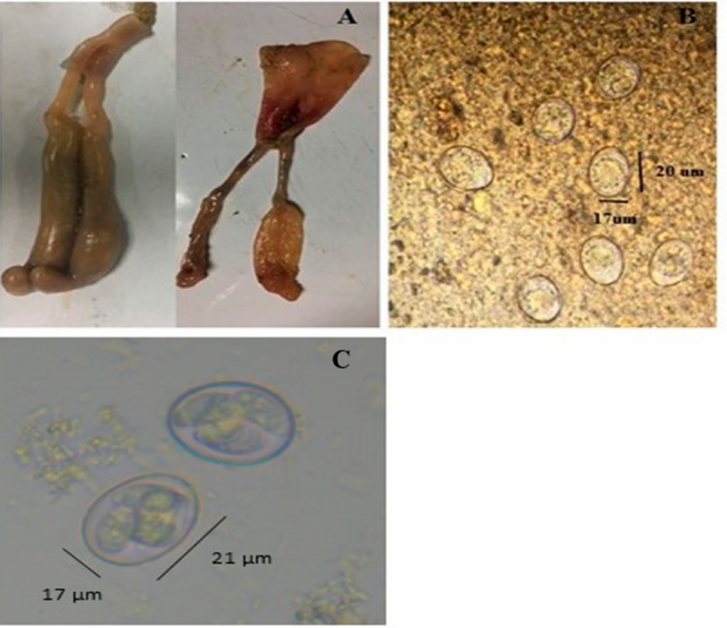
Figure 1. Collection and propagation of different E. tenella life stages from the infected caecum of the chicken: ( A ) Eimeria tenella -infected caecum of 14-day old chicken; ( B ) under the microscope; unsporulated oocysts (from fecal sample of the infected chicken) are denoted by arrows with a width of 17 µ m and a length of 20 µ m; ( C ) sporulated oocysts (converted from unsporulated oocysts to sporulated oocysts) observed under the microscope, denoted by arrows with 17 µ m width and 21 µ